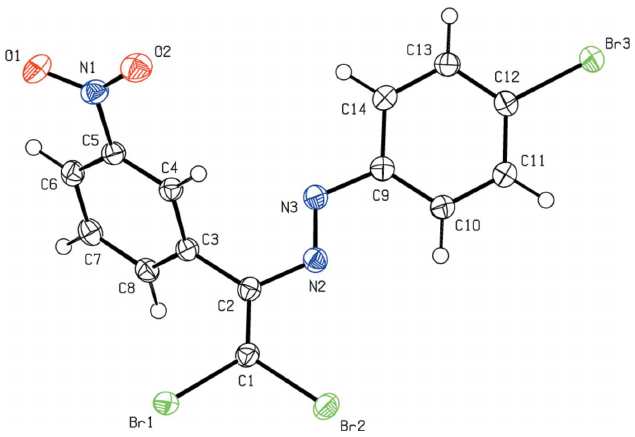
Figure 3 View down the b -axis of the C—H (cid:2)(cid:2)(cid:2) O and (cid:2) – (cid:2) interactions (dashed lines) in the title